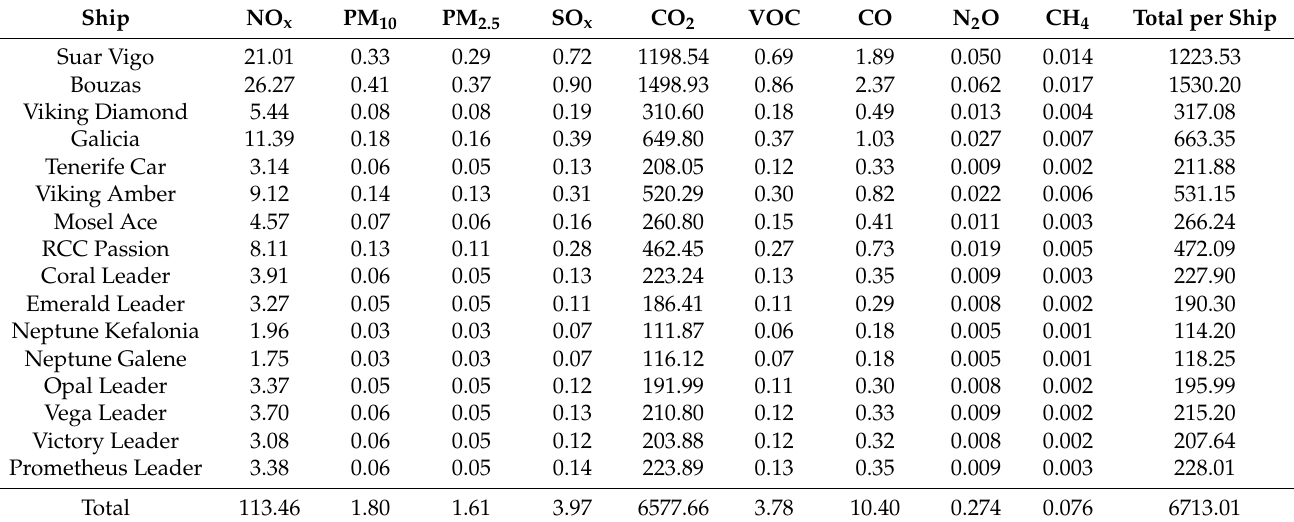
Table 12. Emissions (t/year) calculation from power with 0.1% MGO.